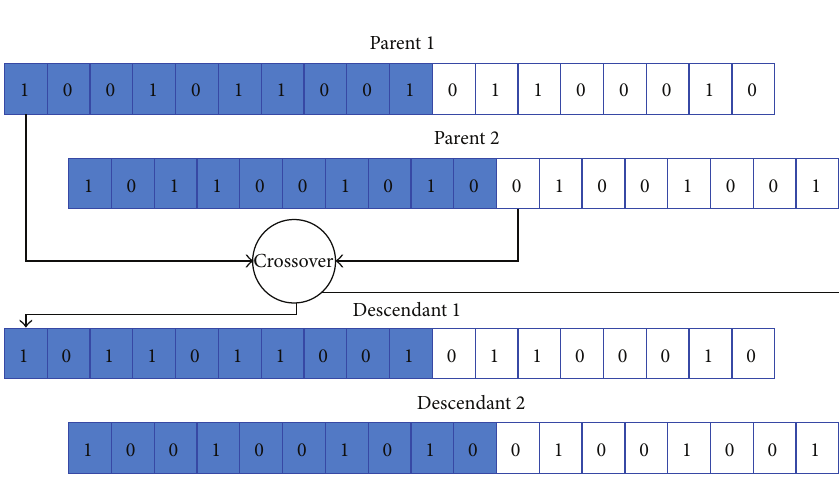
Figure 5: Schematic of encoding rules.